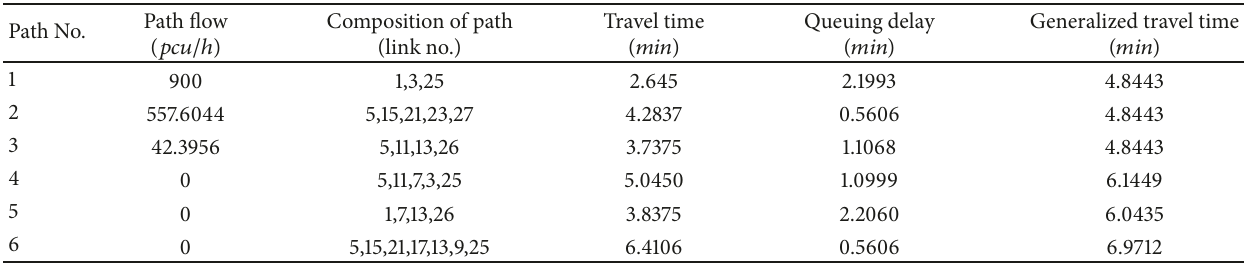
Table 4: Path details of OD pair 1-10 at equilibrium.